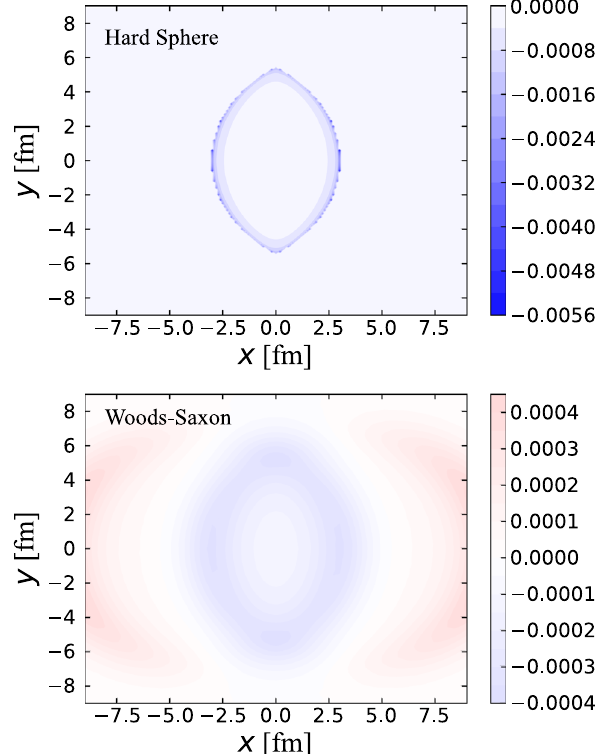
Fig. 3 Initial spatial distribution of polarization in Au–Au collisions √ s NN = 200 GeV with impact parameter b = 6 . 7 fm, compared at between Hard Sphere (upper panel) and Woods–Saxon (lower panel) distributions of nuclear density